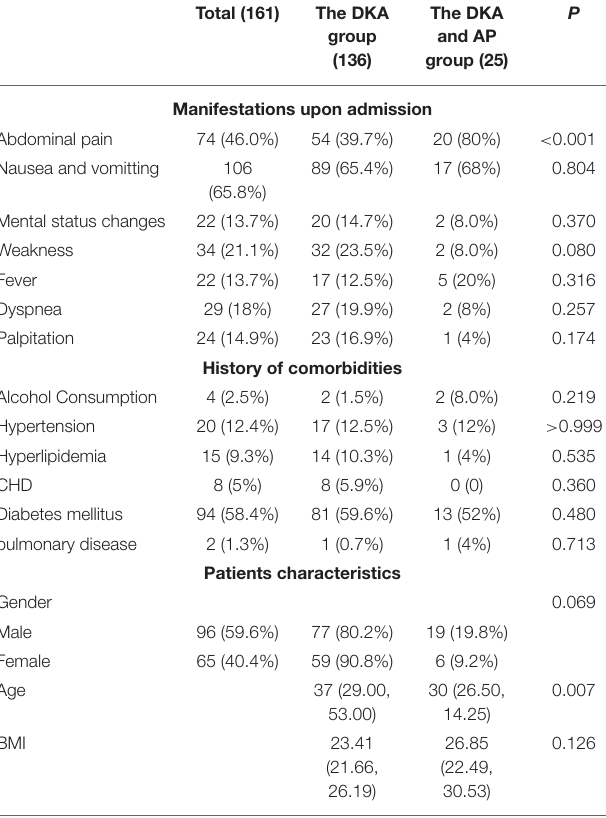
TABLE 1 | Comparison of demographic and clinical characteristics of diabetic ketoacidosis (DKA) patients with and without acute pancreatitis (AP) at admission.